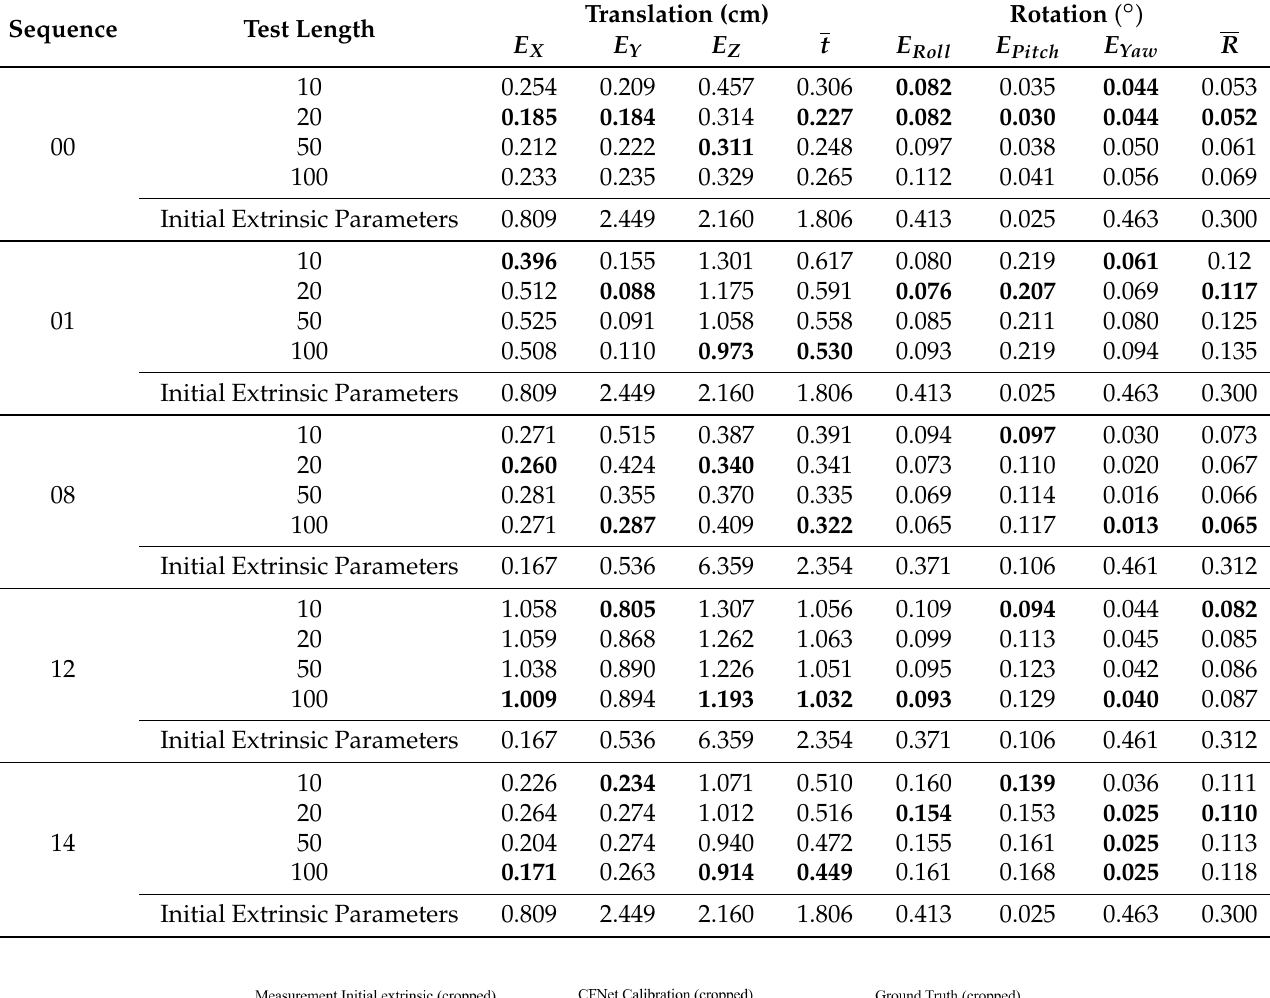
Table 6. The calibration results given initial extrinsic parameters using the KITTI odometry dataset.